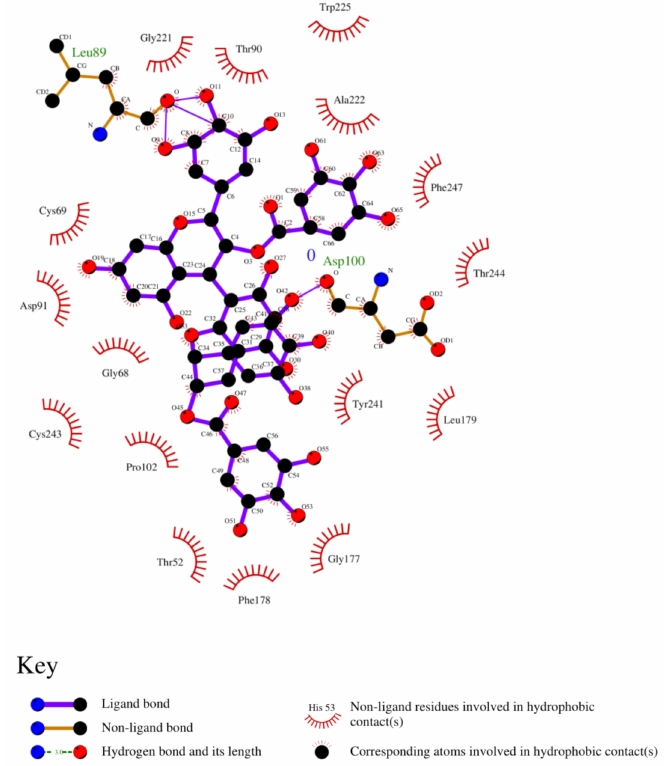
Figure 14. 2D interaction of [(2R,3R)-8-[(2R,3R,4R)-5,7-dihydroxy-3-(3,4,5-trihydroxybenzoyl)oxy-2- (3,4,5-trihydroxyphenyl)-3,4-dihydro-2H-chromen-4-yl]-5,7-dihydroxy-2-(3,4,5-trihydroxyphenyl)- 3,4-dihydro-2H-chromen-3-yl]3,4,5-trihydroxybenzoate and HCV E2